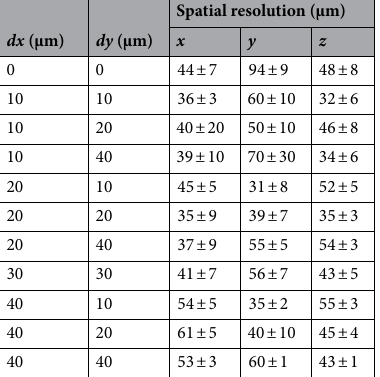
Table 1. Spatial resolution estimates (mean ± one standard deviation) along the x , y , and z direction extracted from the phase images of the sphere phantom, obtained through sub-sampling the dithered dataset using the values of dx and dy given in the left most